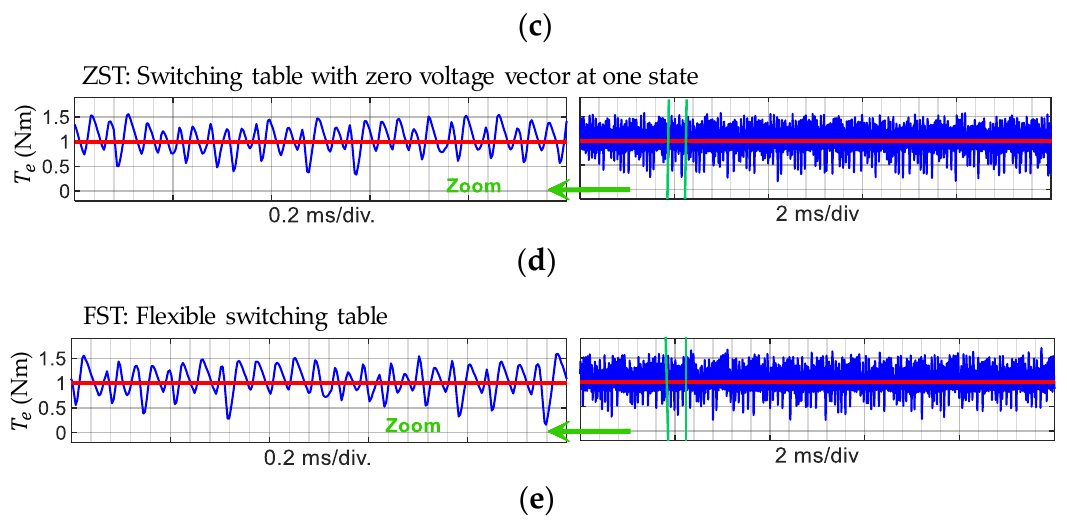
Figure 6. Experimental waveforms of the steady-state torque response at 1000 rpm and 1 Nm load: ( a ) BST; ( b ) MBST; ( c ) AST; ( d ) ZST; ( e ) FST. (Reference torque: red, Estimated torque: